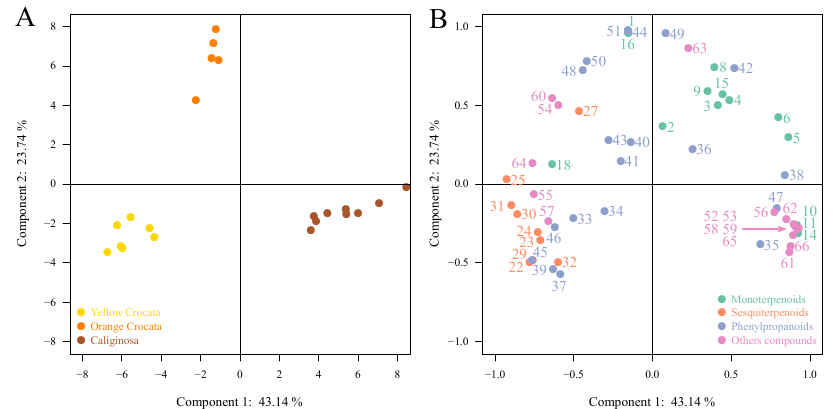
Figure 3. Chemometric analysis of 57 VOCs emitted by the flowers of yellow crocata, orange crocata and T. caliginosa. ( A ) Score plot of PC1 versus PC2 scores. ( B ) Loading plot of PC1 and PC2 contributing volatile compounds.